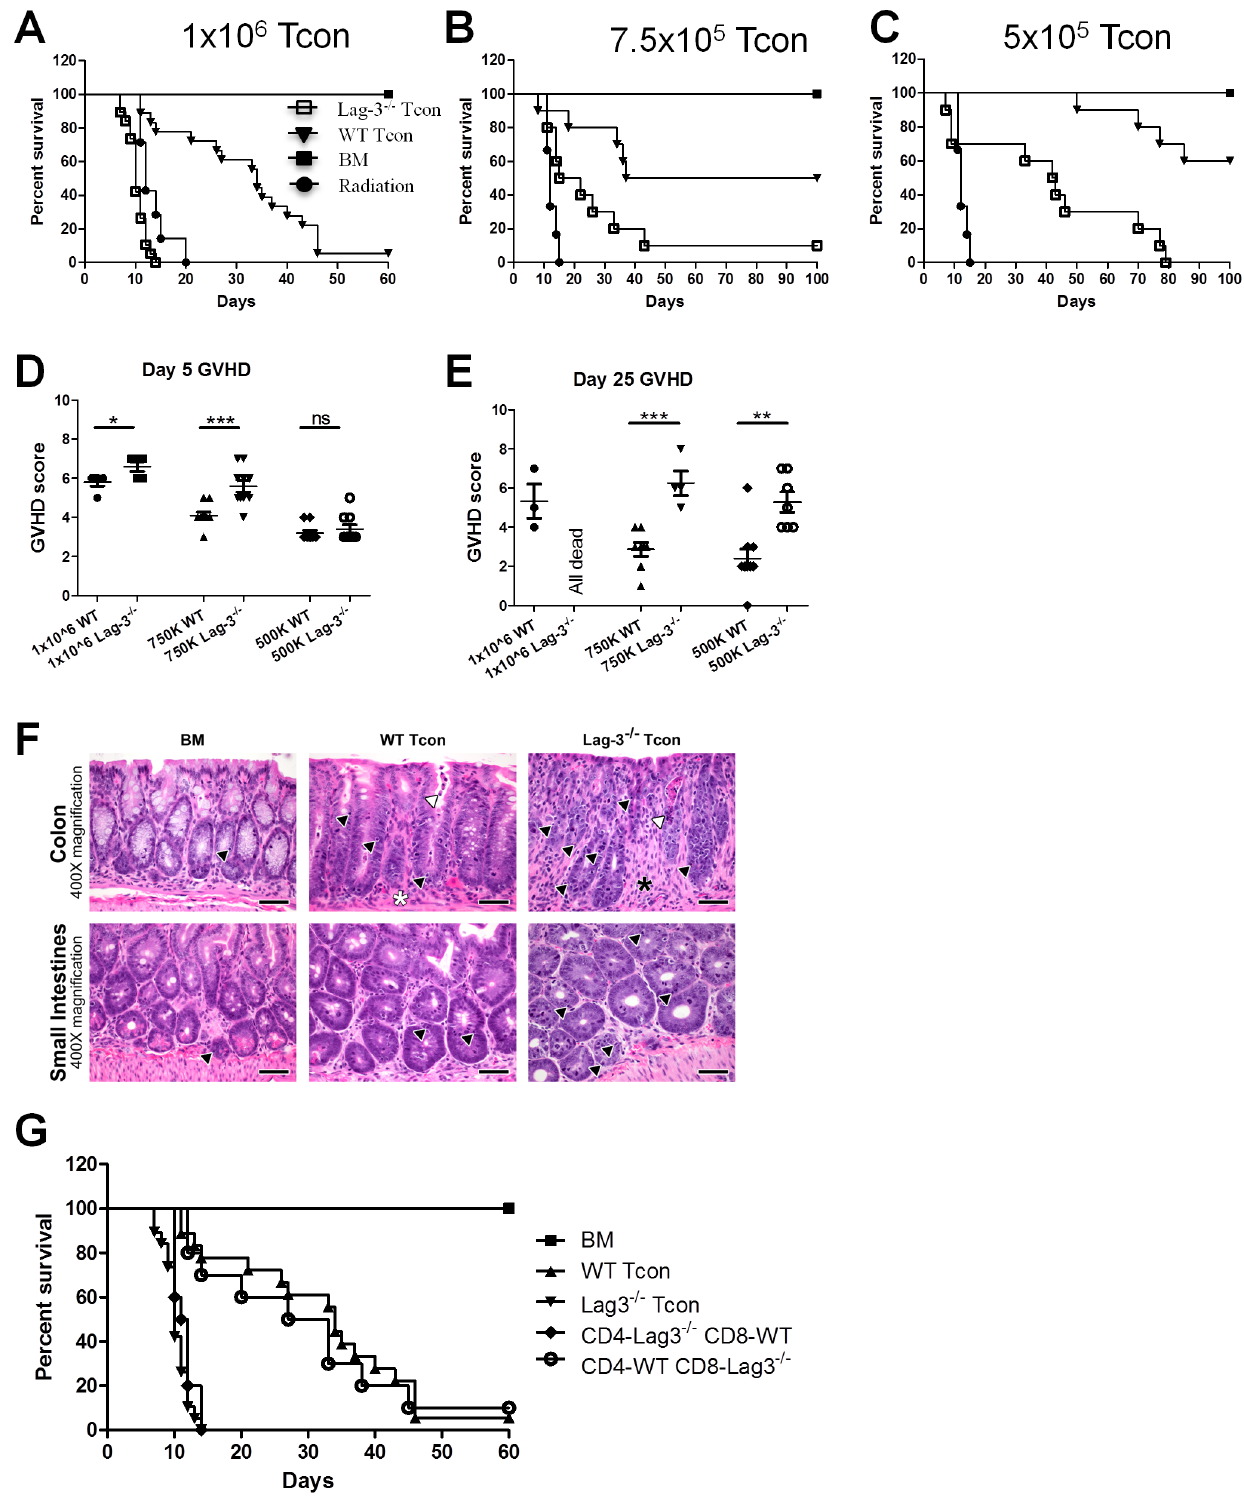
Figure 2. Lag-3 2 / 2 Tcon accelerates GVHD. Lethally irradiated Balb/c recipients were transplanted with 5 6 10 6 TCD-BM and various doses of Tcon from either Lag-3 2 / 2 or WT C57Bl/6 mice and monitored for survival (A–C) and GVHD score (D–E). (A) Mice were infused with TCD-BM and 1 6 10 6 Tcon (n=15/group, P=0.009), (B) TCD-BM and 7.5 6 10 5 Tcon (n=10/group, P , 0.001), and (C) TCD-BM and 5 6 10 5 Tcon (n=10/group, P , 0.001). P value is calculated for survival rate differences between mice receiving Lag-3 2 / 2 Tcon and WT Tcon. Data in graphs are pooled from two independent experiments. (D) and (E) represent the GVHD score of mice 5 days (D) and 25 days (E) after transplantation. Mice receiving TCD-BM and Lag-3 2 / 2 Tcon had a significantly higher GVHD score than mice receiving TCD-BM and WT Tcon (P , 0.005). (F) Histopathologic analysis of GVHD target organs isolated at day 8 after transplant. High magnification photomicrographs of colon (upper panels) and small intestine (lower panels)